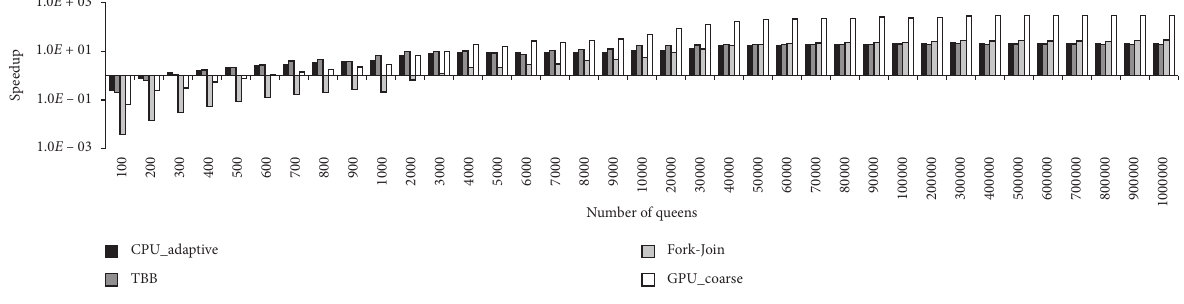
Figure 5: Speedups of schemes in Sections